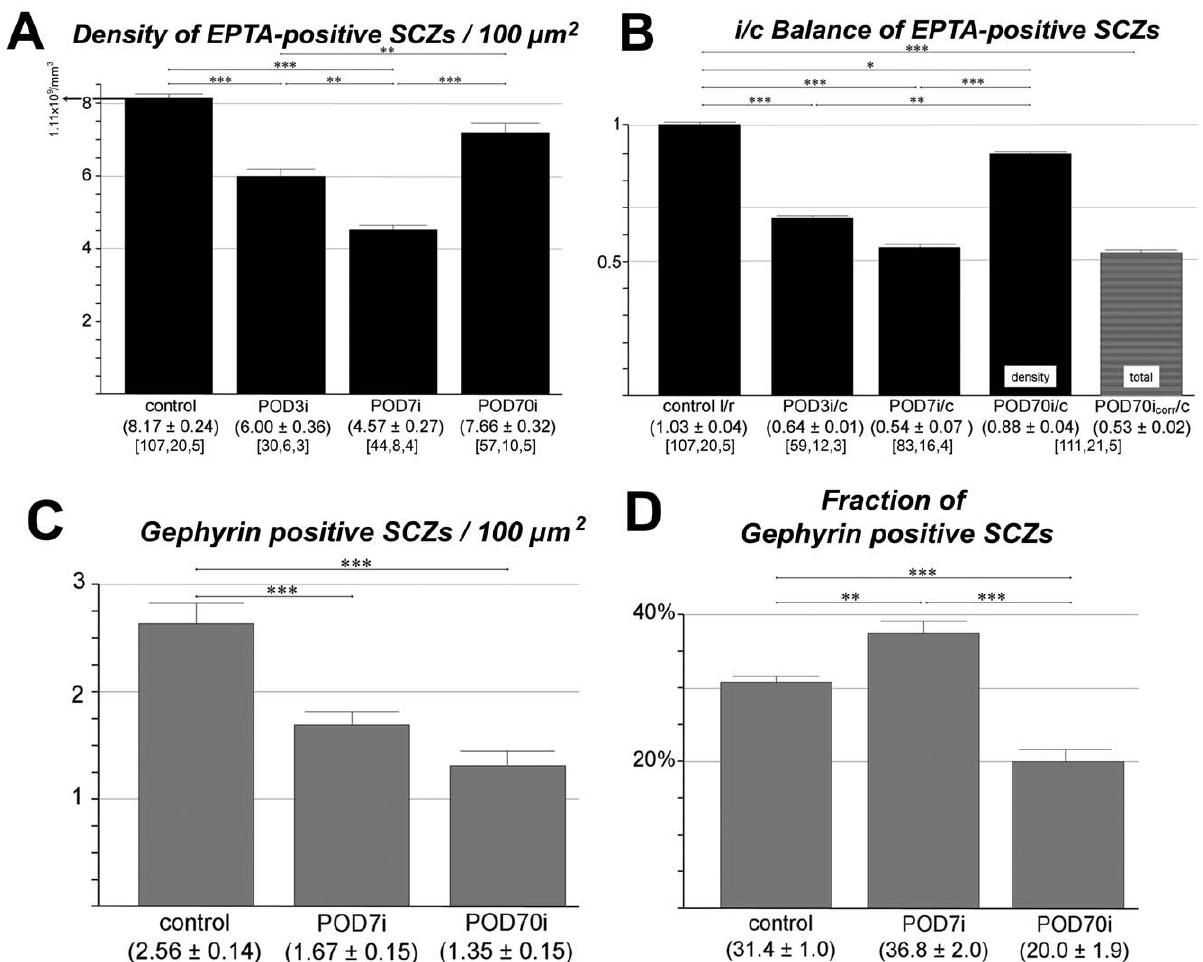
Figure 5. Quantification of EPTA profiles (all SCZs) and gephyrin positive profiles (inhibitory SCZs) before and at various times after cochlear ablation. (A) Progression of SCZ density after sensory deafferentation in the ipsilateral (i) AVCN. (B) Balance of ipsilateral-to- contralateral (i/c) ratio of EPTA stained SCZs; in controls left-to-right (l/r) ratios are given. When corrected for lesion-dependent tissue shrinkage (corr), the total number of SCZs present 10 weeks after cochlear ablation can be estimated (right column). (C) Density of gephyrin-positive profiles before and after cochlear ablation. (D) Fractions of gephyrin labeled SCZs among the population of all EPTA labeled SCZs present at pre- and postoperative stages. Numeric triplets below columns as in Fig. 1.